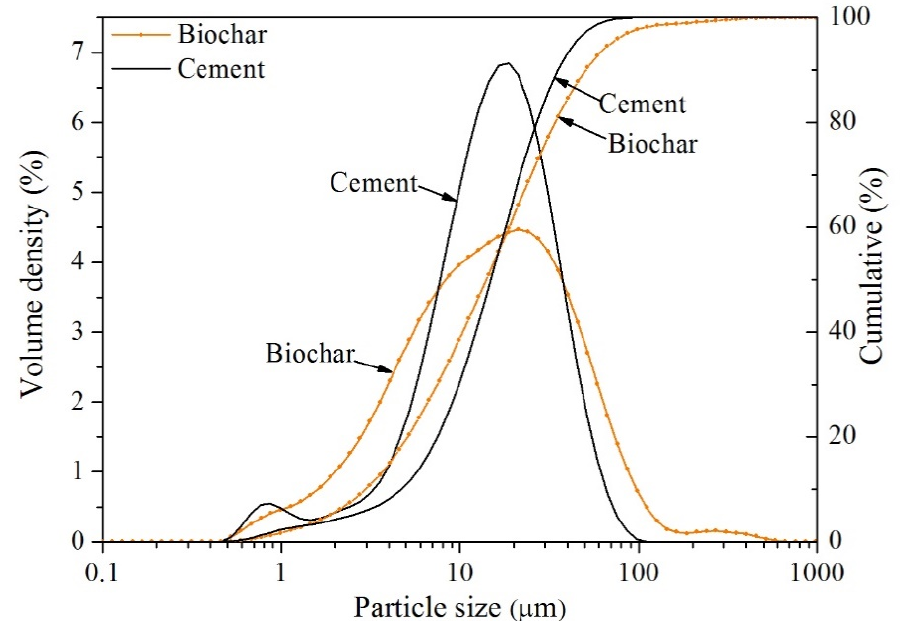
Figure 1. Particle size distributions of biochar and cement. Table 1. Chemical compositions of biochar and cement.